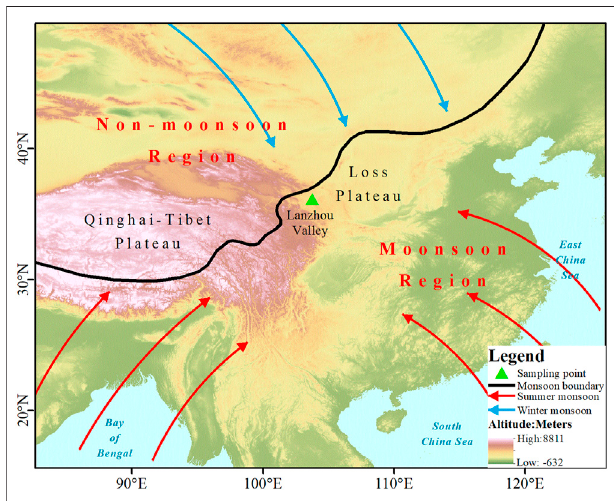
FIGURE 1 | Location of the study area (Lanzhou valley) and sampling pointfeaturebymonsoonandwesterlydualaffection.Themonsoonboundary was de fi ned according to Zhao